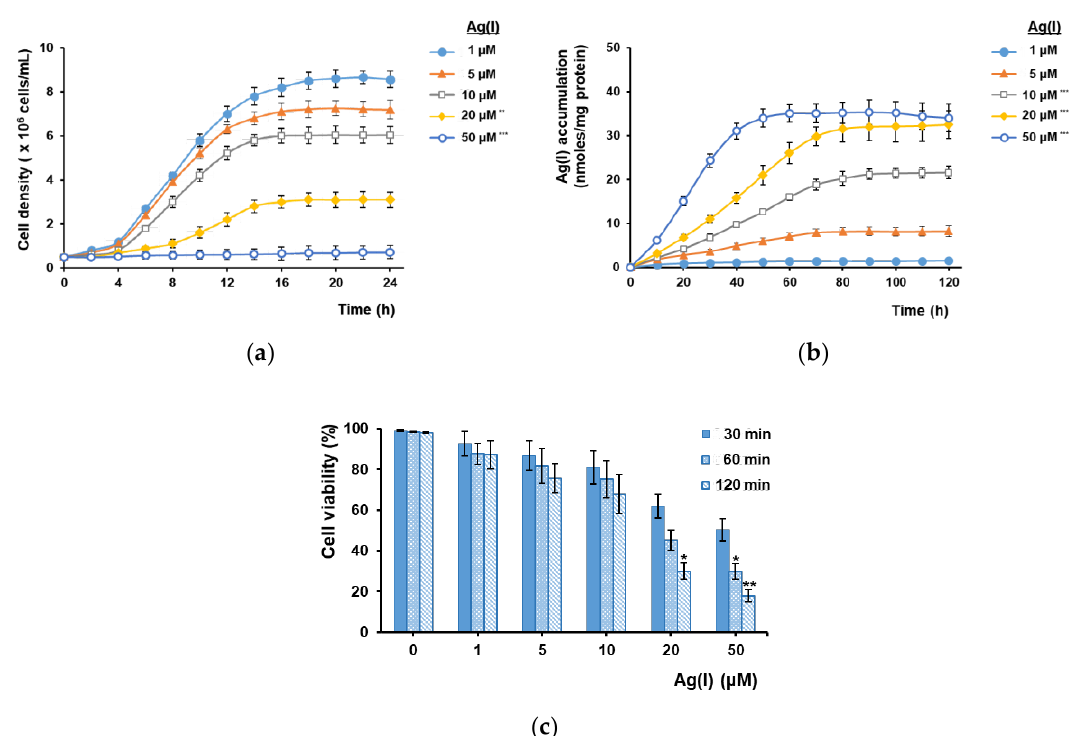
Figure 1. Effect of Ag(I) on S. cerevisiae parental cells. Exponentially growing BY4741 “wild-type” (WT) cells were inoculated in MM/Gal with various Ag(I) concentrations as described in Materials and Methods. ( a ) Effect of Ag(I) concentration on yeast growth as seen by cell proliferation. Cell growth in liquid MM/Gal was not significantly different from cell growth in the presence of 1 µ M Ag(I) and for clarity reasons it is not shown. ( b ) Effect of Ag(I) concentration on Ag(I) accumulation. Total Ag(I) accumulated by cells was determined by ICP–MS and normalized to cell protein. ( c ) Cell viability of cells exposed to Ag(I). The percentage of viable cells was determined at specific time points by staining with methylene blue. One-way ANOVA ( a , b ) followed by Bonferroni’s test compared to low (1 µ M) Ag(I). Two-way ANOVA ( c ) followed by Bonferroni’s test compared to control (no added Ag(I)). * p < 0.05; ** p < 0.01; *** p < 0.001.